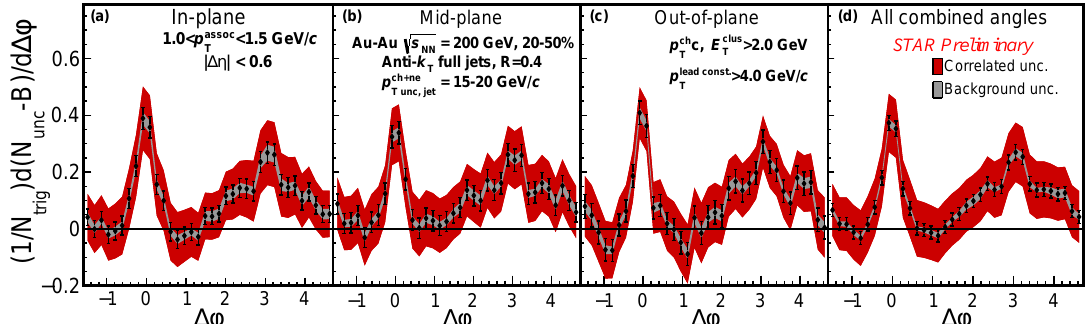
Figure 1. ( a ) In-plane, ( b ) mid-plane, ( c ) out-of-plane, and ( d ) all combined angles of trigger jets relative to the second-harmonic event plane for corrected ∆ φ correlation function for 1.0 < p T < 1.5 GeV/ c √ s NN = 200 GeV for the 20–50% most associated hadrons for R = 0.4 full jets in Au–Au collisions at central events. The red band corresponds to the correlated uncertainty and the gray band corresponds to the RPF background [10] uncertainty which is non-trivially correlated